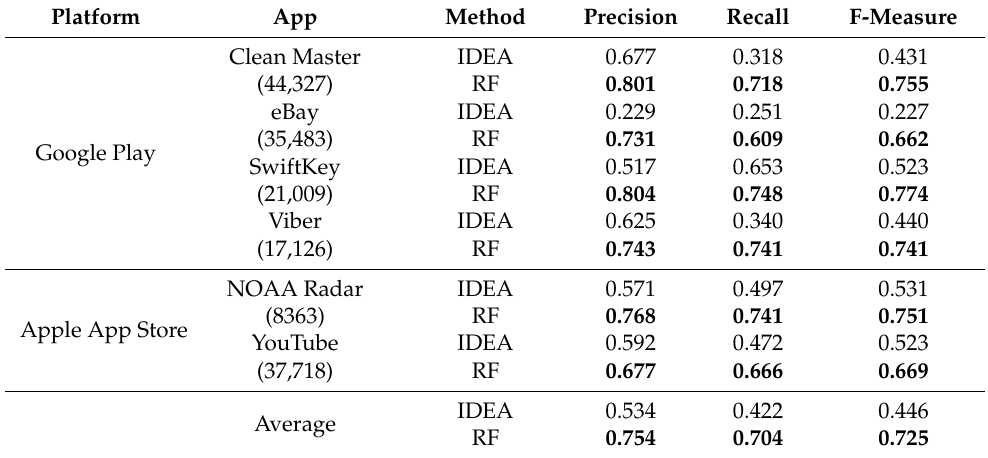
Table 7. Performance comparison with IDEA (the number under app name is the total number of